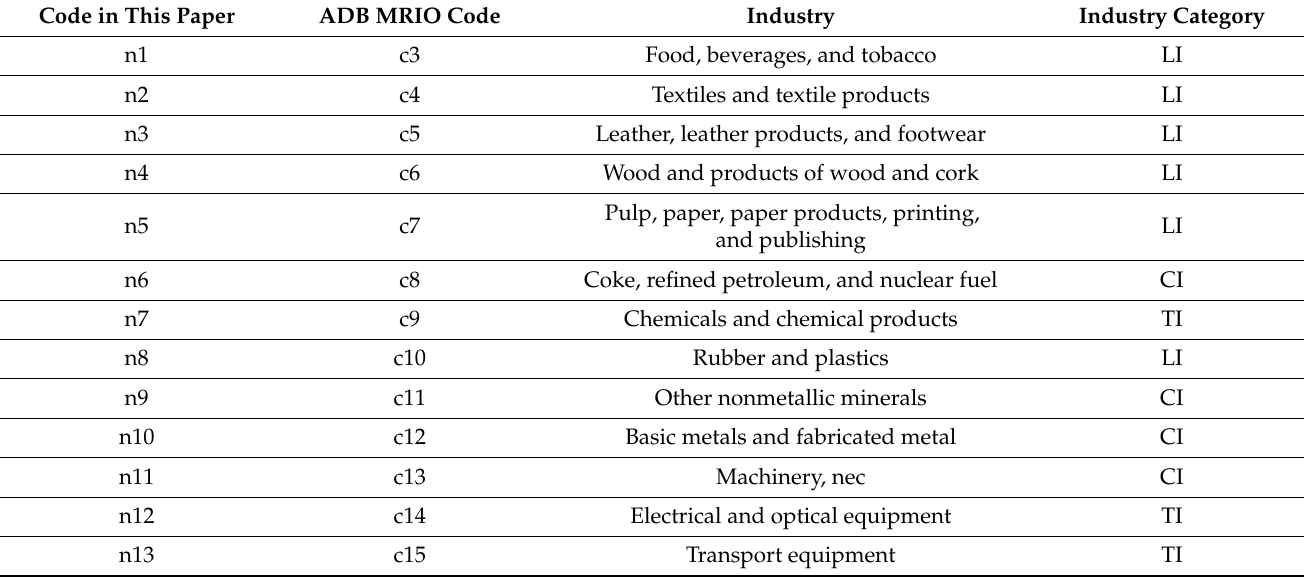
Table 2. Manufacturing Industry